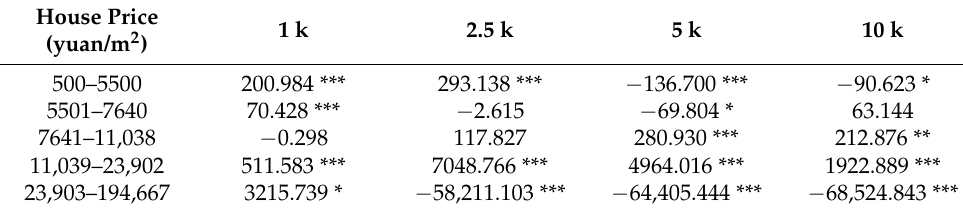
Table 4. Relationship between housing price and Gini coefficient of UGS